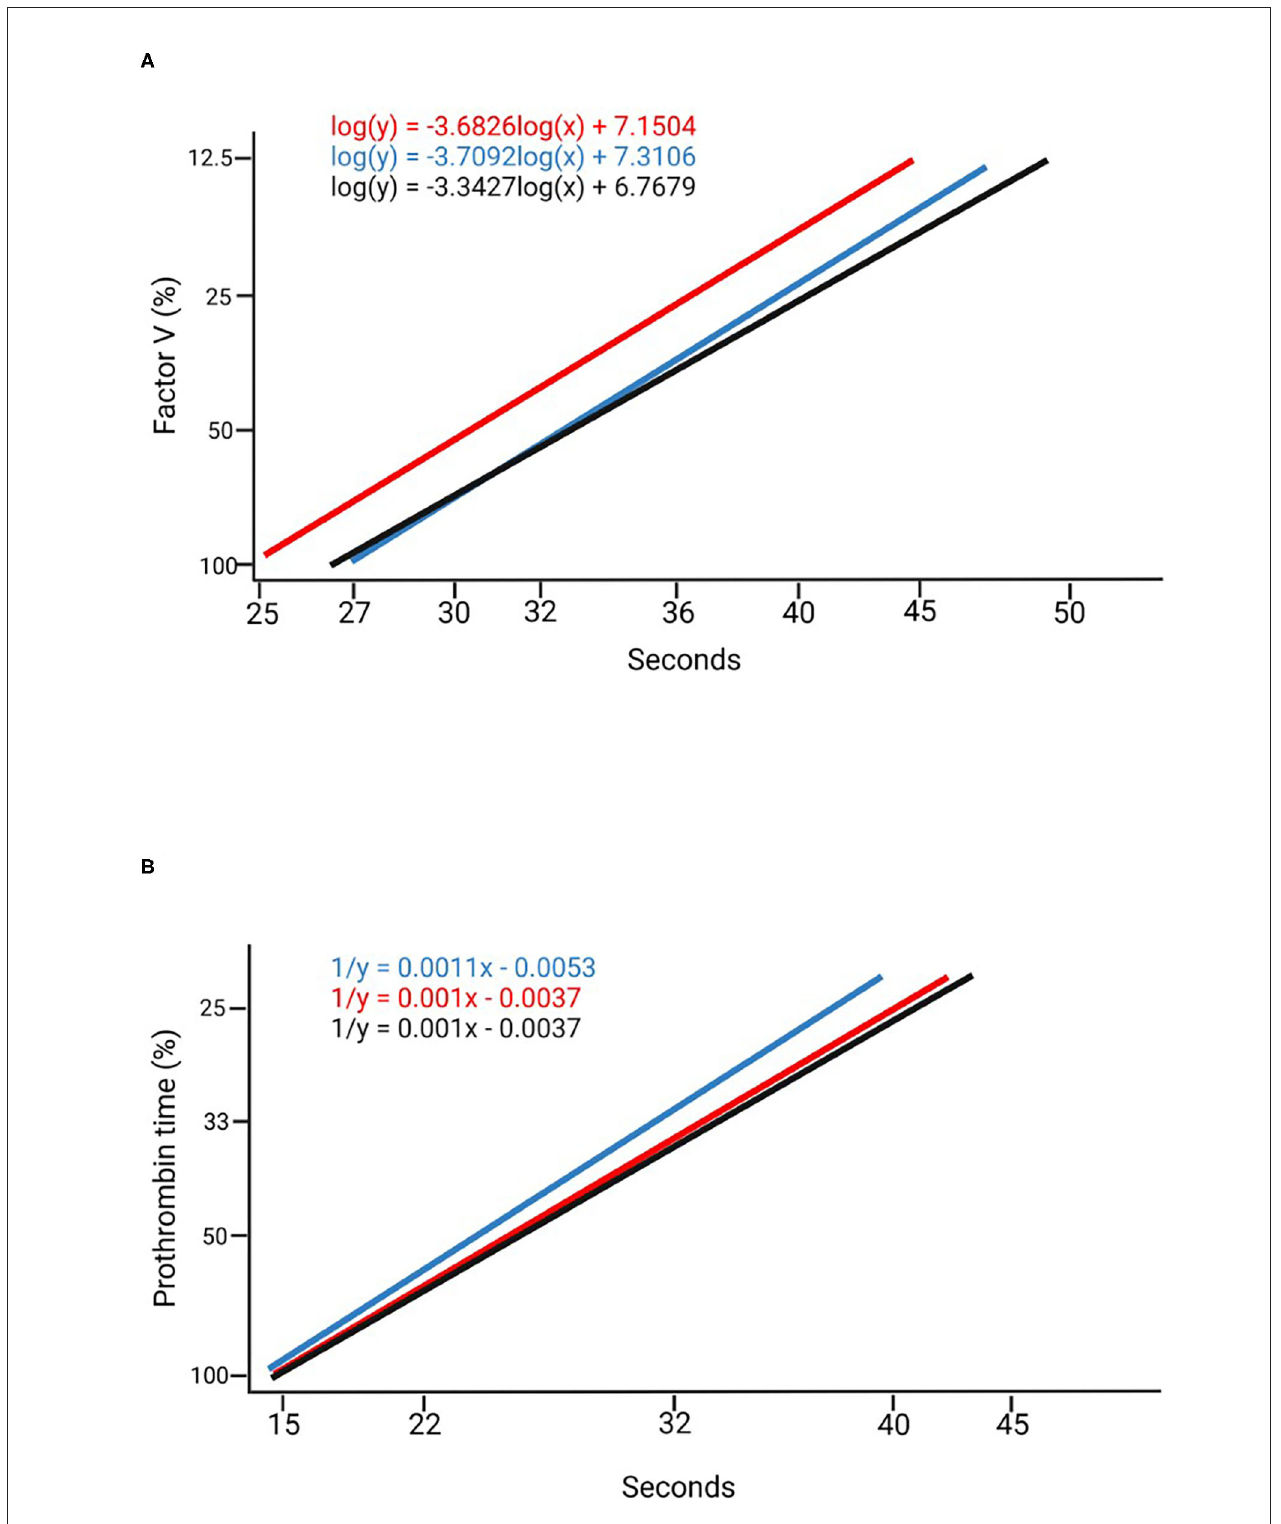
FIGURE 1 | Calibration curves. (A) Factor V calibration curves created using a commercially available calibrator (blue), in a 1:100 dilution at Dark 0 (black) and a 1:100 dilution at Ligth 0 (red). (B) Prothrombin time calibration curves created with a commercially available calibrator (blue) in a 1:3 dilution at Dark 0 (black) and a 1:3 dilution at Ligth 0